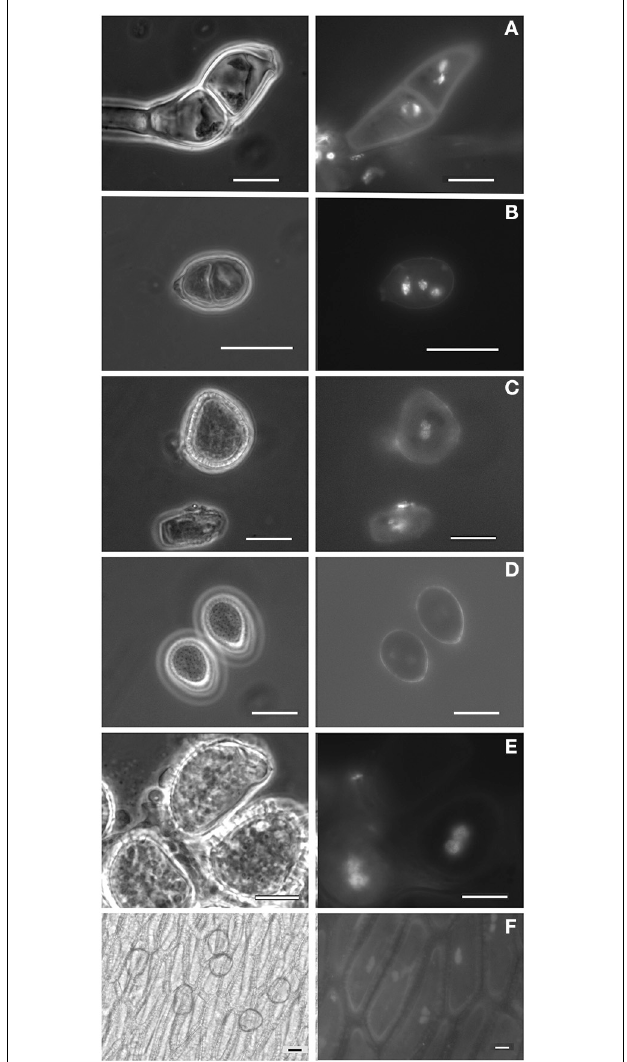
FIGURE 2 | Spores (and other cells) from Pucciniales under phase-contrast microscopy and showing the DAPI-stained nuclei under fluorescence light. (A) Teliospore from Puccinia malvacearum ; (B) Teliospore from Puccinia smyrnii ; (C) Aeciospore from Puccinia smyrnii ; (D) Urediniospores from Phragmidium mexicanum ; (E) Urediniospore from Hemileia vastatrix ; (F) Pseudoperidia cells and aeciospores from Gymnosporangium confusum . Bars, 10 μ